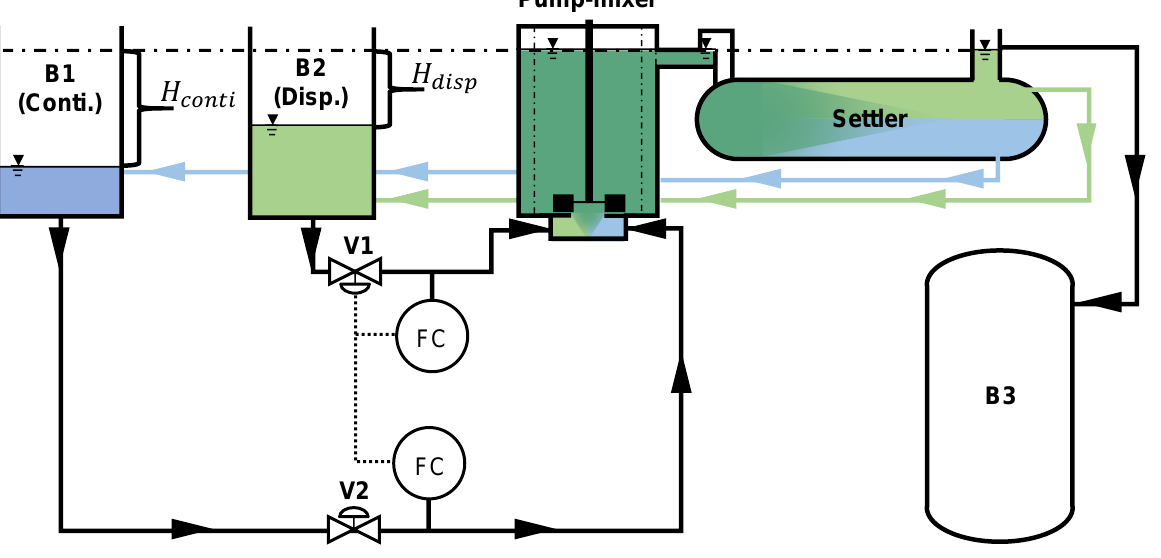
Figure 1. Scheme of the DN300 pump-mixer-settler.